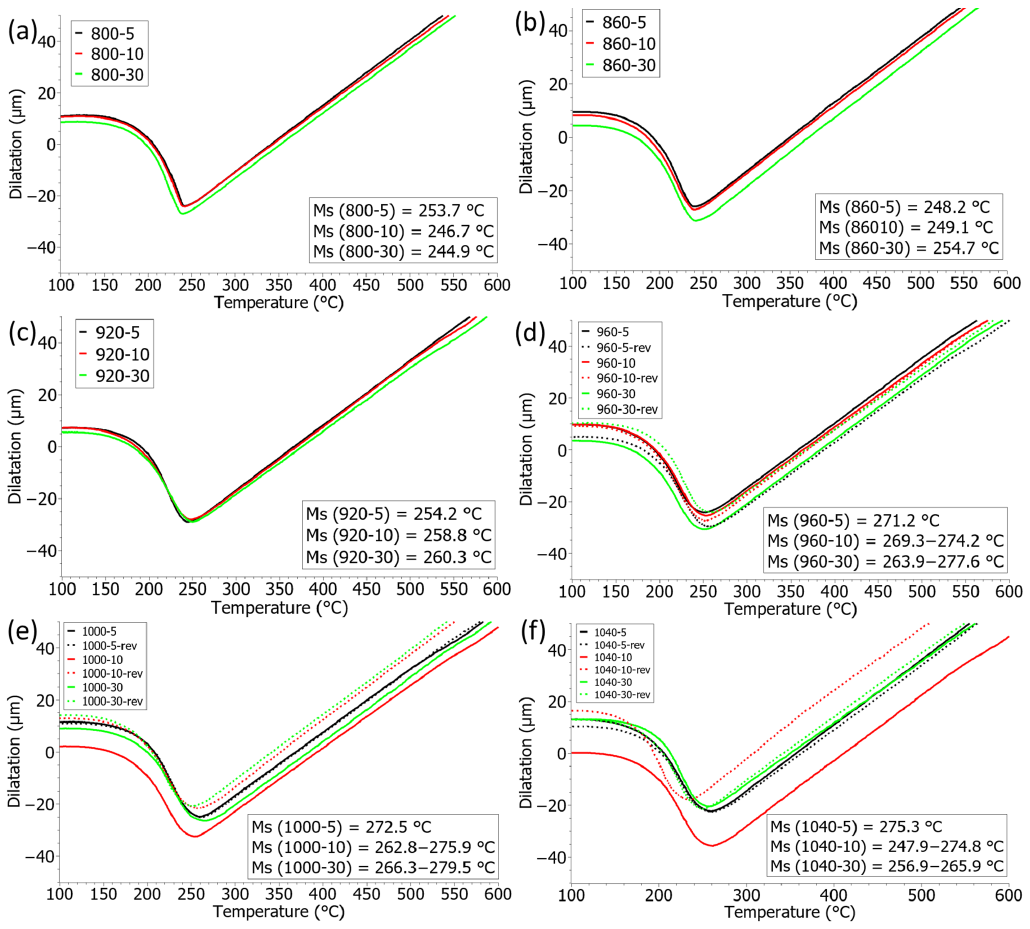
Figure 10. Dilatometric cooling curves from different austenitisation temperatures ( a ) 800 °C, ( b ) 860 °C, ( c ) 920 °C, ( d ) 960 °C, ( e ) 1000 °C, ( f ) 1040 °C.